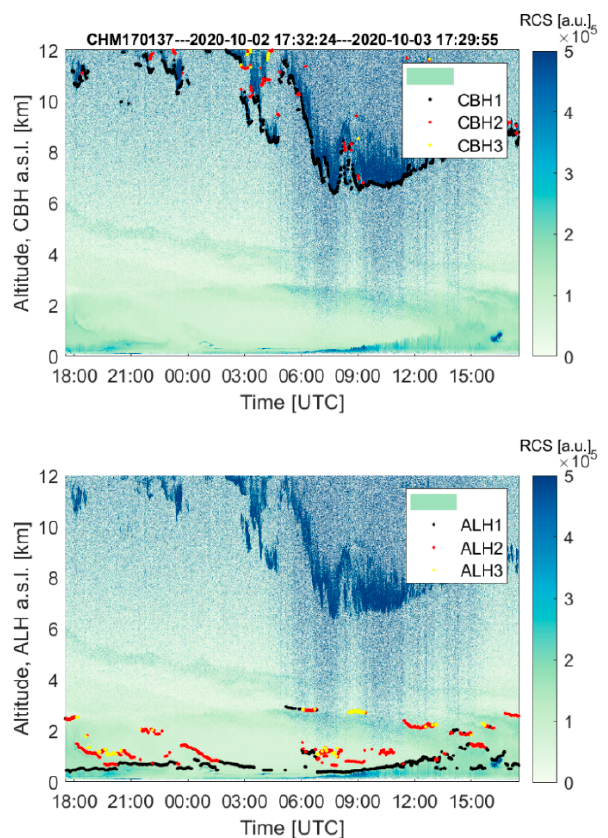
Figure 3. RCS over the last 24 h with overlaps of CBH (upper plot) and ALH (lower plot). The time interval for the last 24 h is shown in the title.